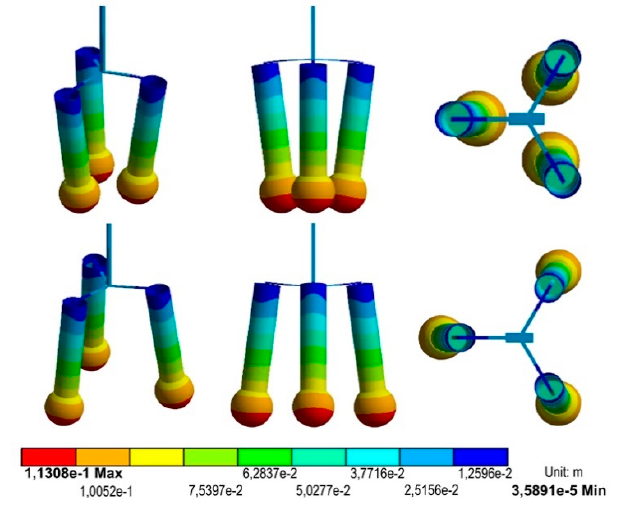
Figure 8. The first resonant mode obtained by Ansys code eigenmode analysis.